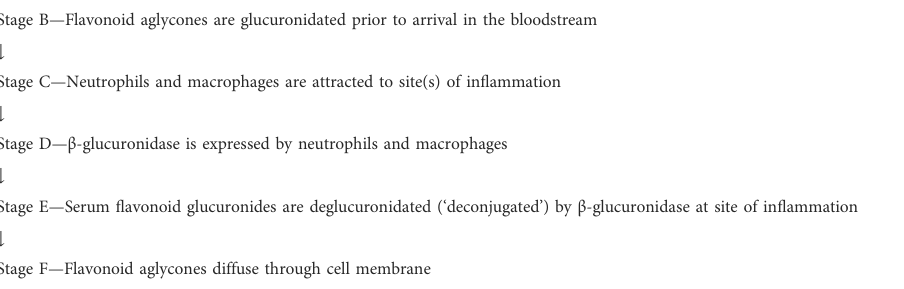
TABLE 1 Deglucuronidation-through-in fl ammation mechanism